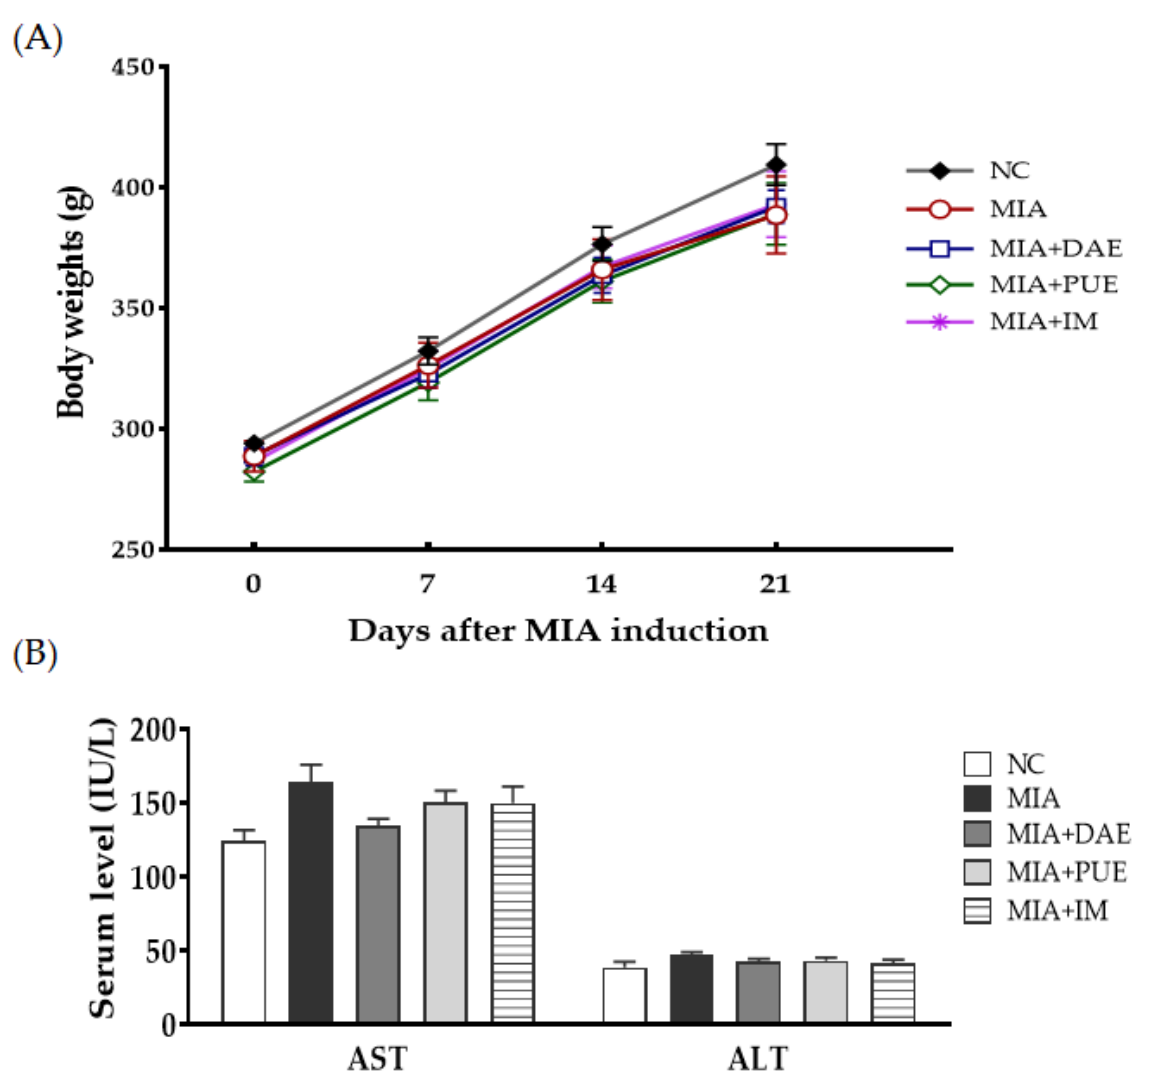
Figure 1. Effects of Dipsacus asperoides extract (DAE) and Phlomis umbrosa extract (PUE) on body weight and serum amino- transferase levels in MIA-induced OA rats. ( A ) The body weight of rats was measured once per week for 3 weeks. ( B ) Serum aspartate aminotransferase (AST) and alanine aminotransferase (ALT) levels. Data are expressed as the mean ± SEM ( n = 7 per group). NC, untreated; MIA, only MIA-induced; MIA + DAE, MIA-induced and DAE-treated; MIA + PUE, MIA-induced and PUE-treated; MIA + IM, MIA-induced and Indomethacin (IM)-treated rats.